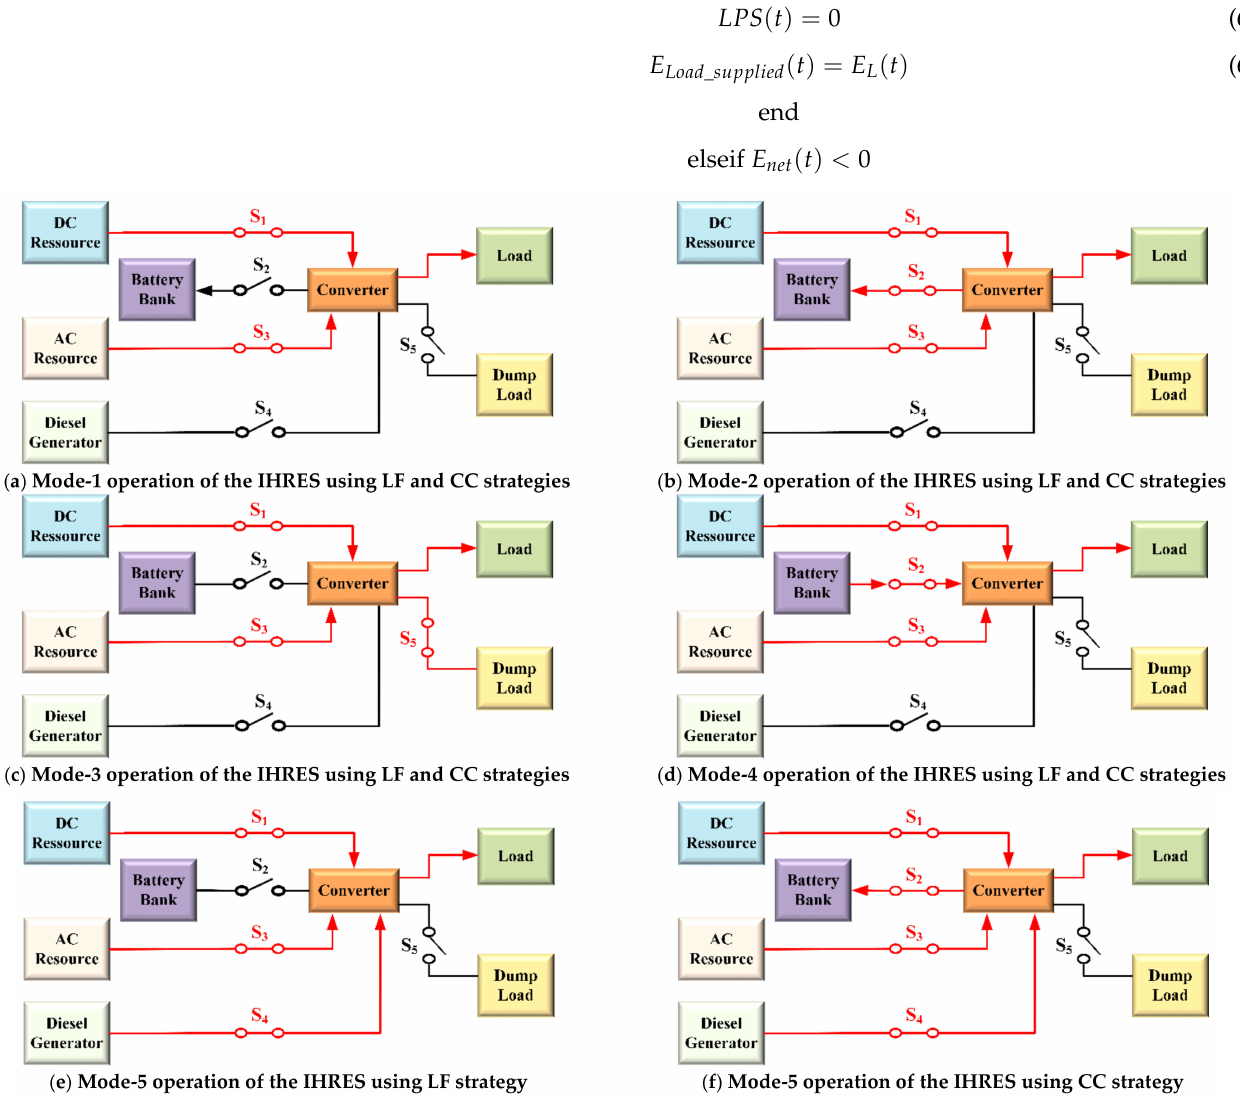
Figure 10. Operating modes of the IRES using LF and CC